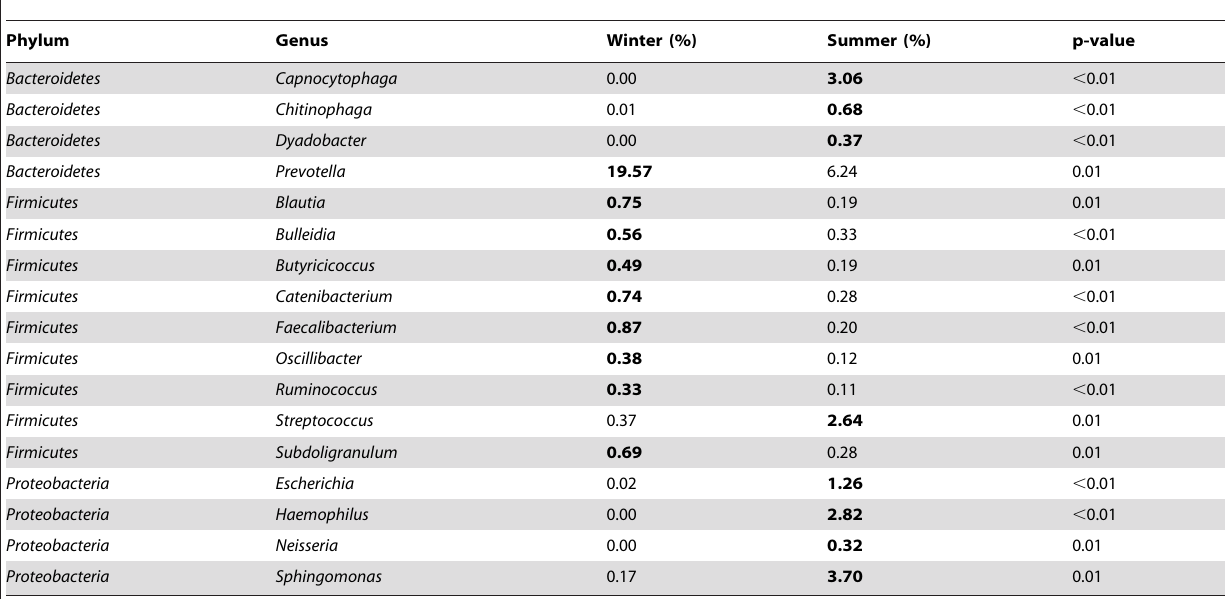
Table 4. Differentially abundant bacterial genera in swine confinement buildings sampled during winter and summer seasons.